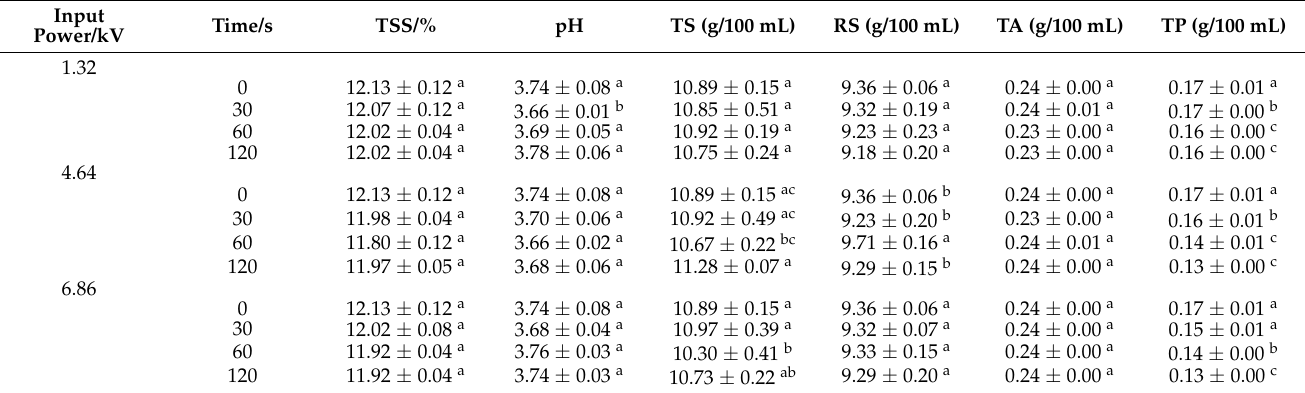
Table 2. Effects of input power (1.32, 4.64, and 6.86 kV) and treatment time (0, 30, 60, 120, and 360 s) on the physicochemical indicators of apple juice after cold plasma treatment.